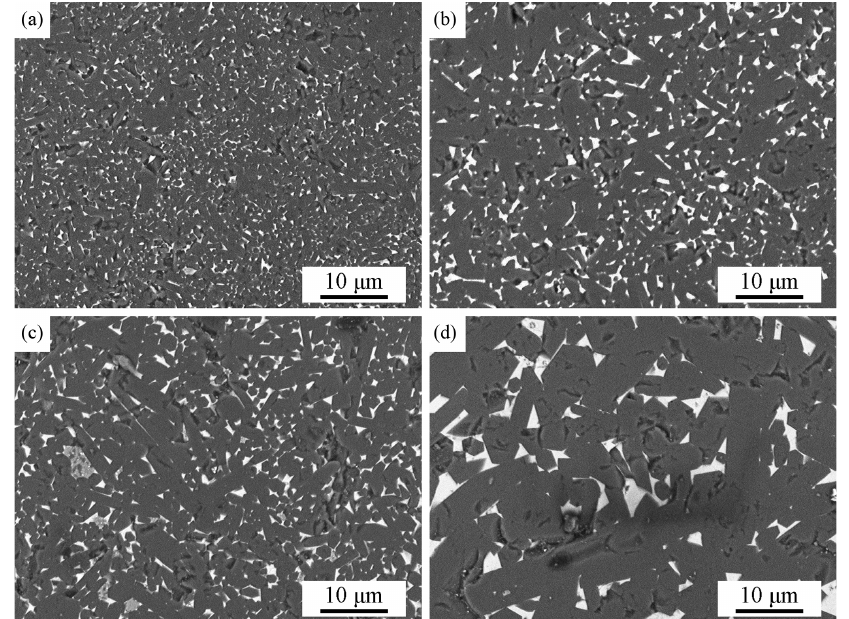
Figure 5: BSE micrographs of PSRB- β -SiAlON, (a) Z = 0.5, (b) Z = 1, (c) Z = 2, (d) Z =